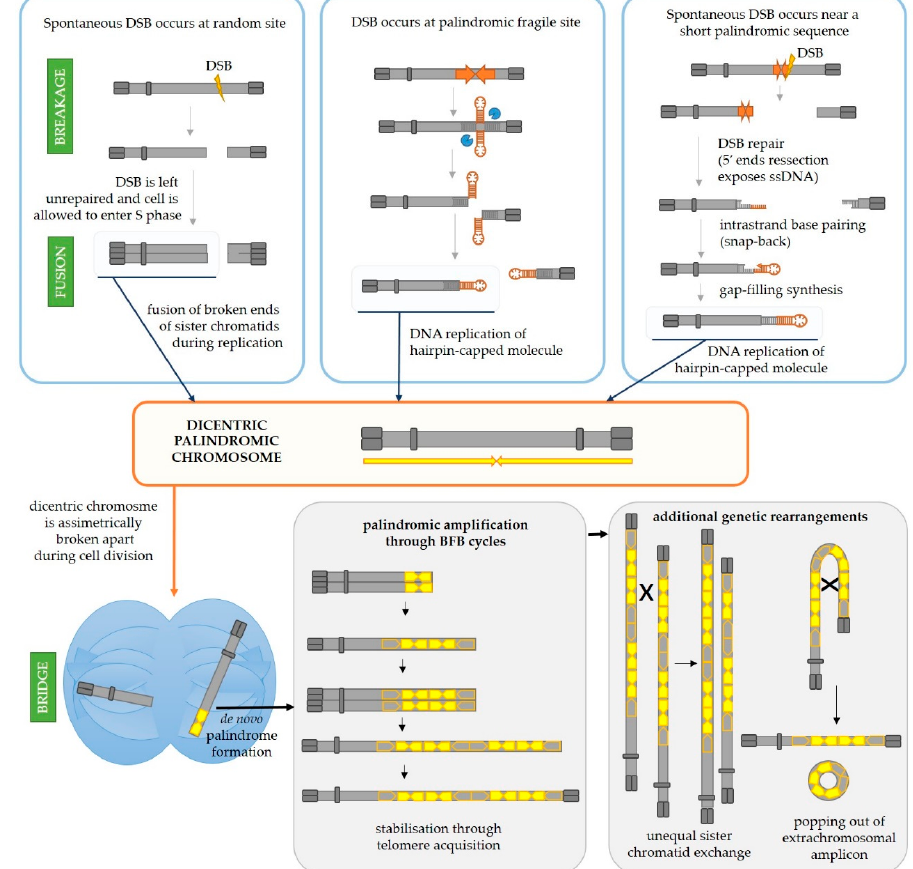
Figure 3. Mechanisms responsible for initiation of de novo palindrome formation followed by subsequent palindromic amplifications and additional genetic rearrangements typical for cancer cells. On the left upper panel, the initial steps of the breakage-fusion-bridge (BFB) mechanism are shown. If a DSB is left unrepaired and the DNA is subsequently replicated, the broken ends of sister chromatids can fuse to form two palindromic chromosomes, one of which will be dicentric. Middle and right upper panels depict alternative mechanisms for formation of a palindromic dicentric chromosome, an initiating event for palindromic amplification. In the middle panel, a DSB is mediated by a secondary structure-forming palindrome in the genome. As explained in detail in Section 2, this results in hairpin-capped DSB ends. If left unprocessed, the replication of the centromere-proximal hairpin-capped molecule results in an dicentric chromosome. On the upper right panel, the fold-back priming mechanism is depicted. If a DSB occurs in the vicinity of a palindrome or short inverted repeats, the DSB repair, which normally involves 5 ′ end resection, will expose the repeats in the ssDNA form. This can allow for intrastrand base pairing (fold-back) and the folded 3 ′ -end can then serve as a primer for gap-filling DNA synthesis. The resulting hairpin-capped molecule can also lead to occurrence of a dicentric chromosome upon DNA replication. Regardless of the initial mechanism of formation, the palindromic dicentric chromosome can be asymmetrically broken during cell division and one of the resulting chromosomes will carry a de novo formed palindrome (palindromic duplication). Additional BFB cycles can result in palindromic amplifications of certain genomic regions and such chromosome could at some point become stabilized by telomere addition, thus breaking iterations of BFB cycles (lower middle panel). However, additional genetic rearrangements and gene copy number gains or losses can arise through unequal sister chromatid exchange and intrachromosomal recombination between the acquired repeats which can result in the popping out of an extrachromosomal amplicon (double minute chromosome), also a typical feature of cancer cells.